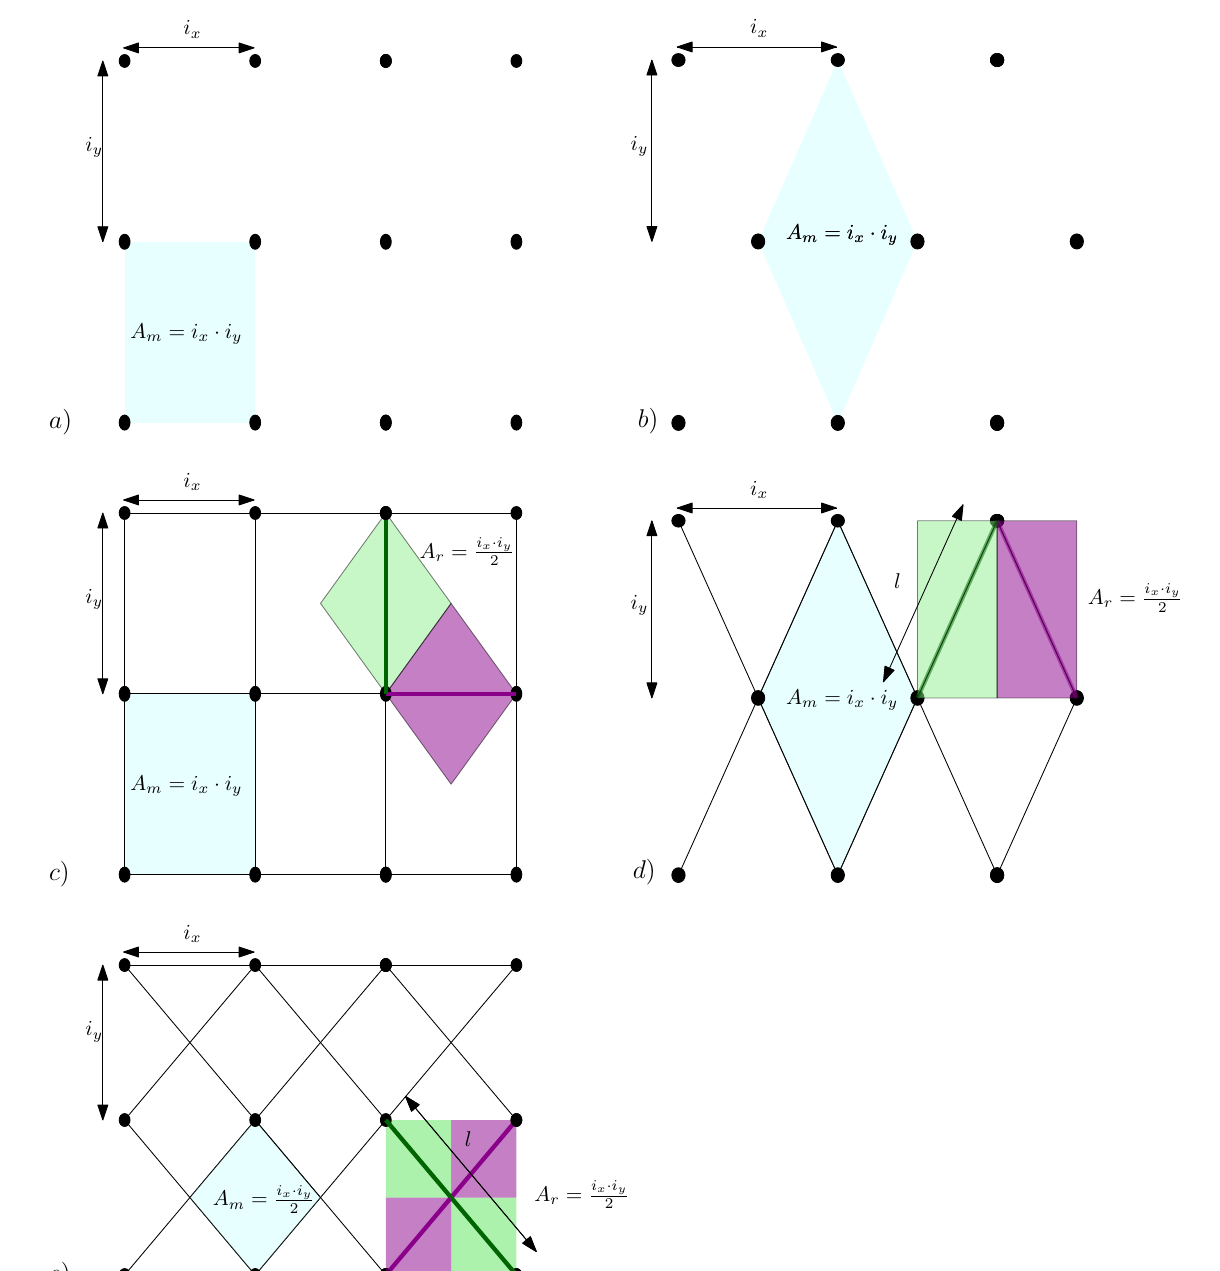
Figure 4. Sketch of the areas of influence of the mesh A m in absence of ropes with a squared ( a ) or quincunx ( b ) anchor pattern, and sketch of mesh and ropes A r with a squared ( c ) or large ( d ) and small ( e ) rhomboidal rope pattern. For a given rope, l represents the distance between